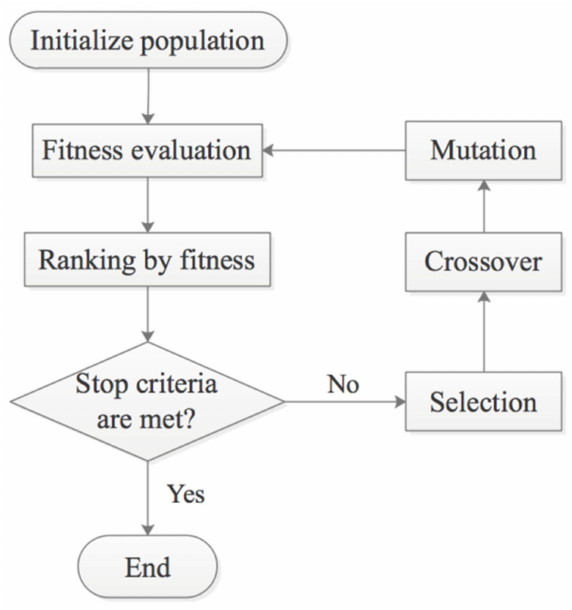
Figure 22. Flow chart of